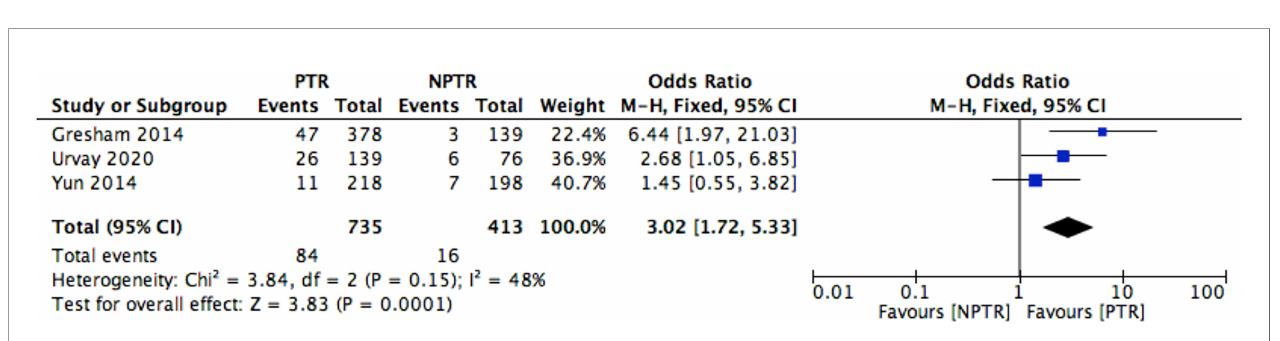
FIGURE 6 | 5-year OS rate Forest.